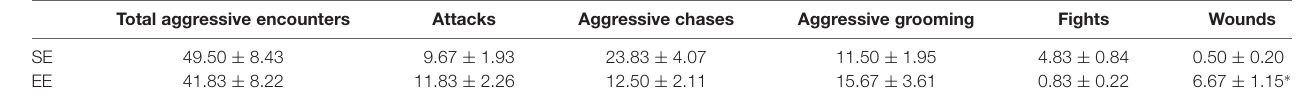
TABLE 1 | Mean ± SEM of home-cage aggressive behaviors over the 6-week housing period among mice housed in a standard environment (SE) or an enriched environment (EE). Total aggressive